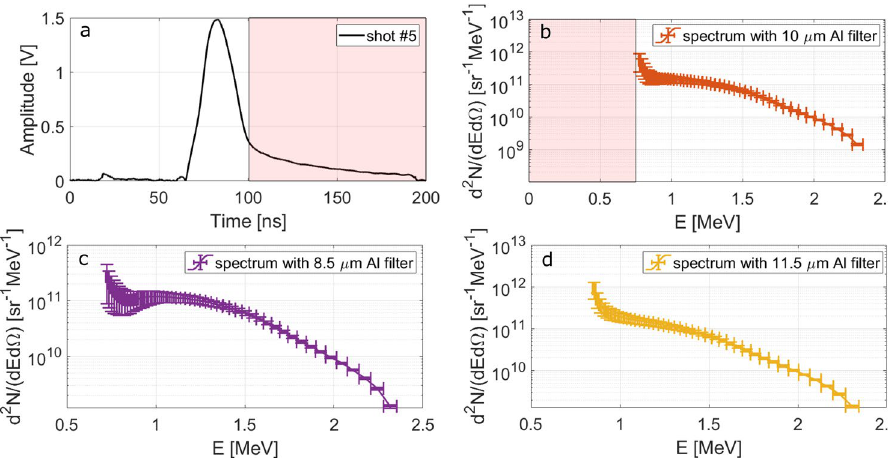
Figure 4. ( a ) Signal obtained for shot #5 with the Al filter covering the diamond detector. ( b – d ) Proton spectrum obtained for this shot by taking into account the effect of the Al filter of thickness 10 µm ( b ), 8.5 µm ( c ) and 11.5 µm ( d ).